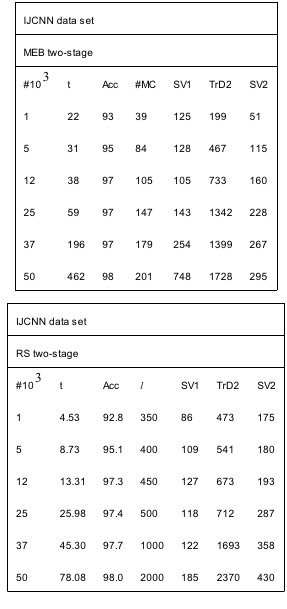
Table 1. Two-stage SVM classification results on IJCNN 2001 data